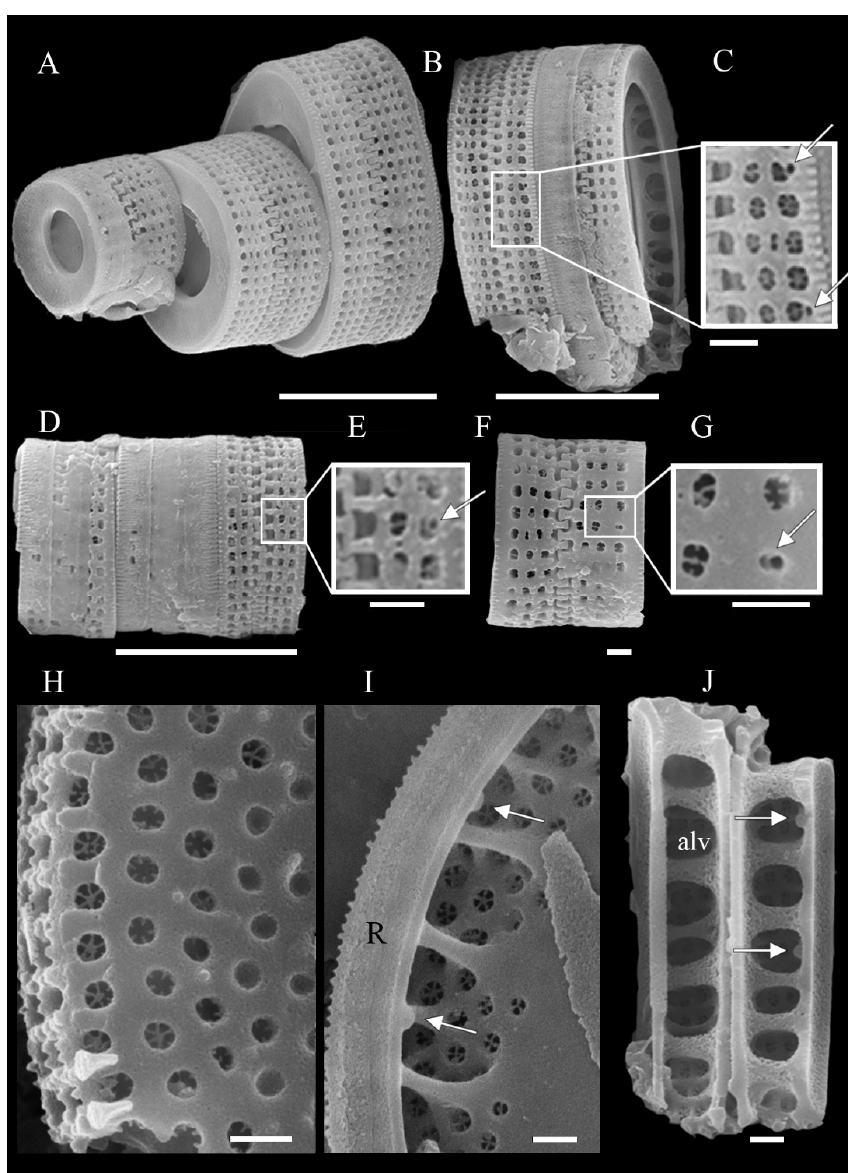
Figure 8. Alveolophora antiqua in the depth range of 61 to 55 m from core 517 of the Barguzin Valley: ( A , B , D , F )—external views, showing variability of valves; ( C , E , G )—fragments of valves, showing areolae and external opening of rimoportulae; H —areolae on the valve face; ( I , J )—internal views showing a ringleist (R), areolae, rimoportulae (arrows) and alveolae. SEM. Scale bar: 10 µm ( A , B , D ) and 1 µm ( C , E – J ).